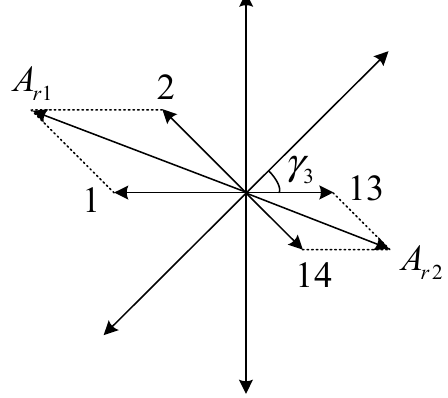
Figure 7. Slot electrical potential star Vectogram ( p = 3).